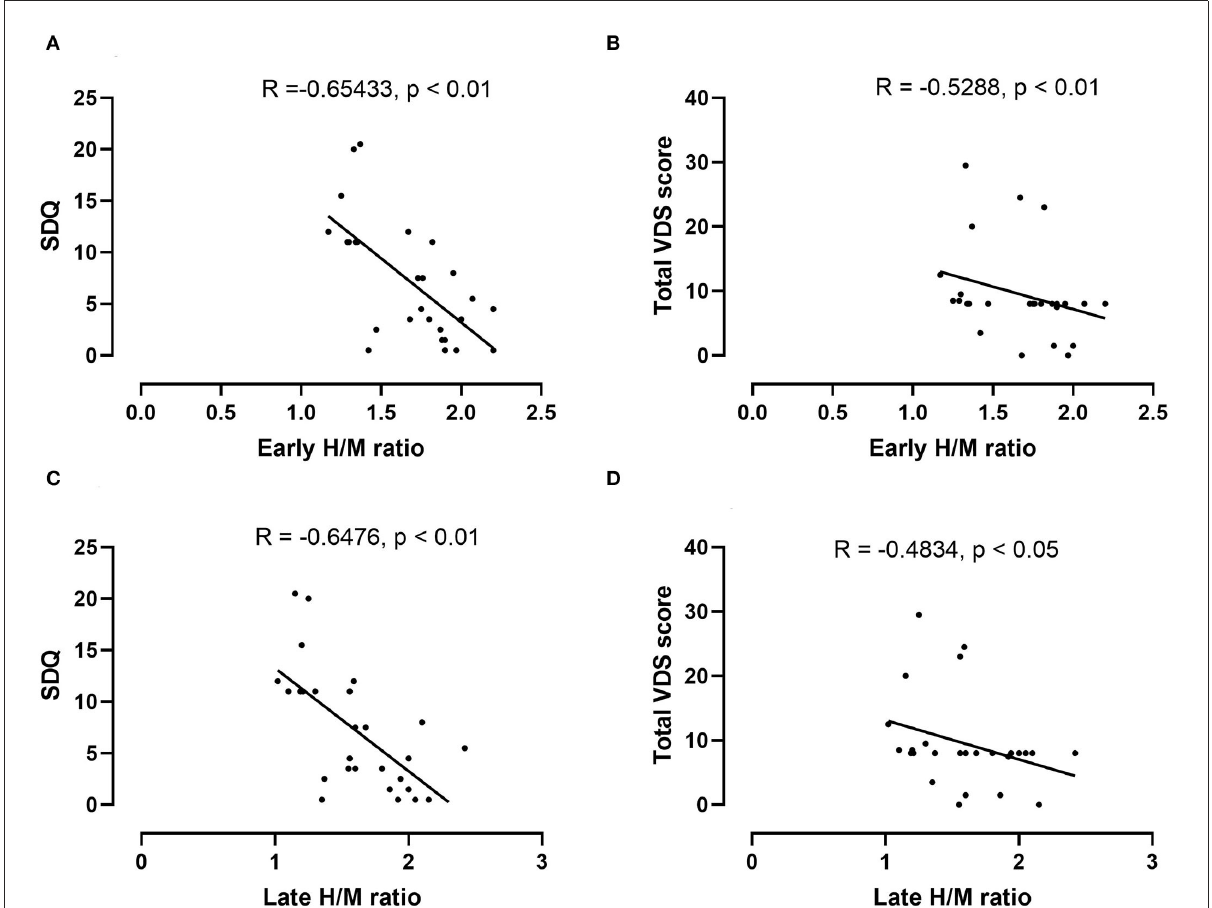
FIGURE2 Correlation analysis between the early H/M ratio and the SDQ (A) and total VDS scores (B) in the PD dysphagia group. There was a significant negative correlation between the early H/M ratio and the SDQ ( r = − 0.65, p < 0.01) and total VDS scores ( r = − 0.53, p < 0.01). In the correlation analysis between the late H/M ratio and the SDQ (C) and total VDS scores (D) , the late H/M ratio also shows a similar negative correlation with the SDQ ( r = 0.65, p < 0.01) and total VDS scores ( r = − 0.48, p <